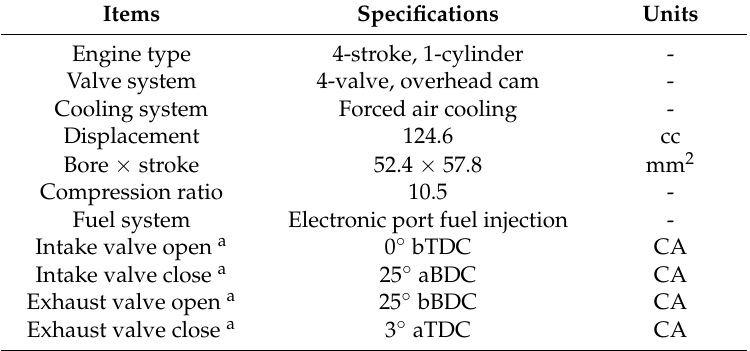
a Valve timing is defined at 1 mm of valve lift.